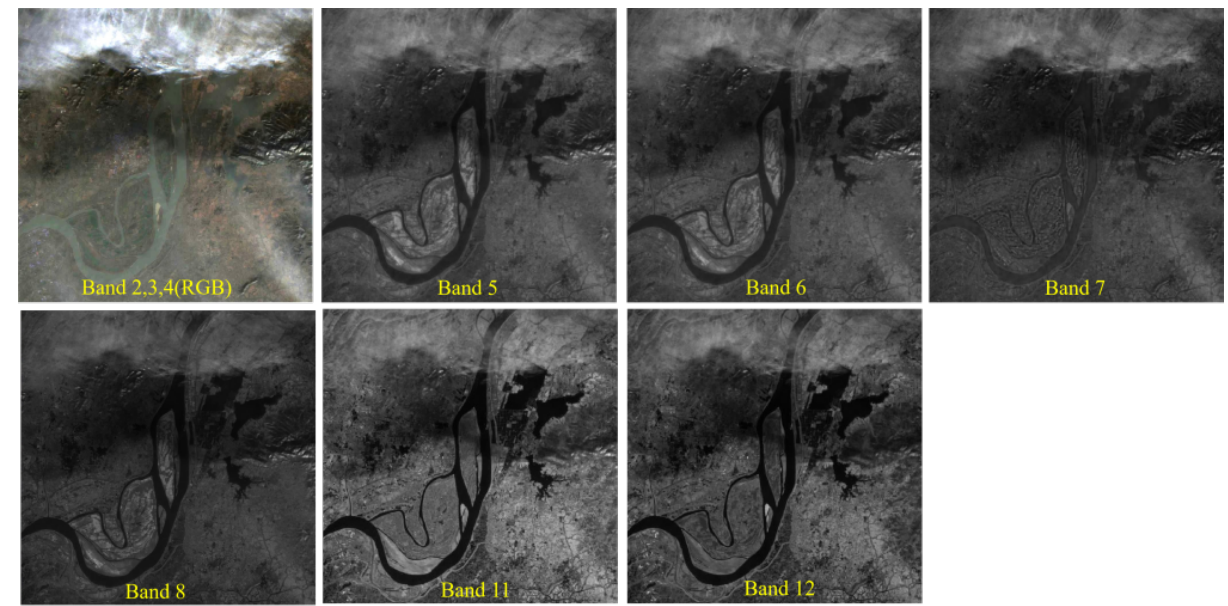
Figure 1. The visible (RGB) band and the infrared bands in the image captured by